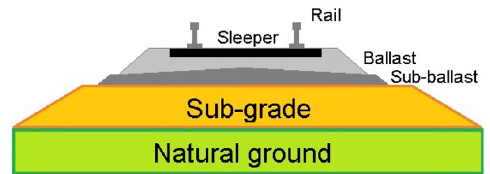
Fig. 1. Railway track structure